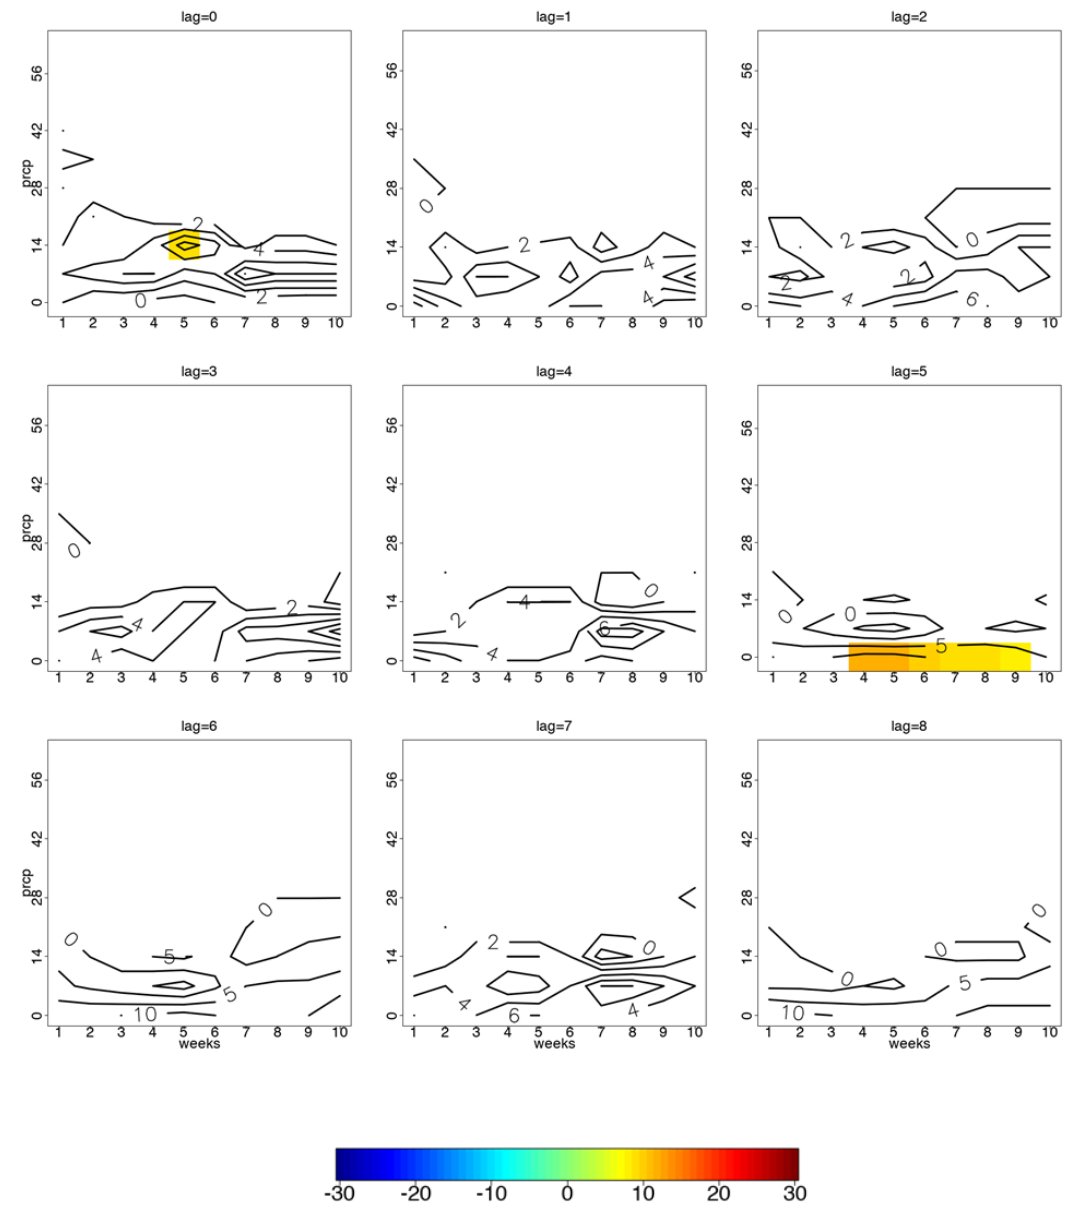
Figure 6. Statistically significant contour differences in anomalously high and low diarrhoea case counts for lag 0 to 8 weeks per consecutive weeks of precipitation among individuals under 5 years of age for season SON. X-axis represents number of consecutive weeks in which the average precipitation reached over Y-axis representing rainfall in millimetres (mm). Warm colours represent higher frequency of (X, Y) occurring when diarrhoea case counts were anomalously higher than average.